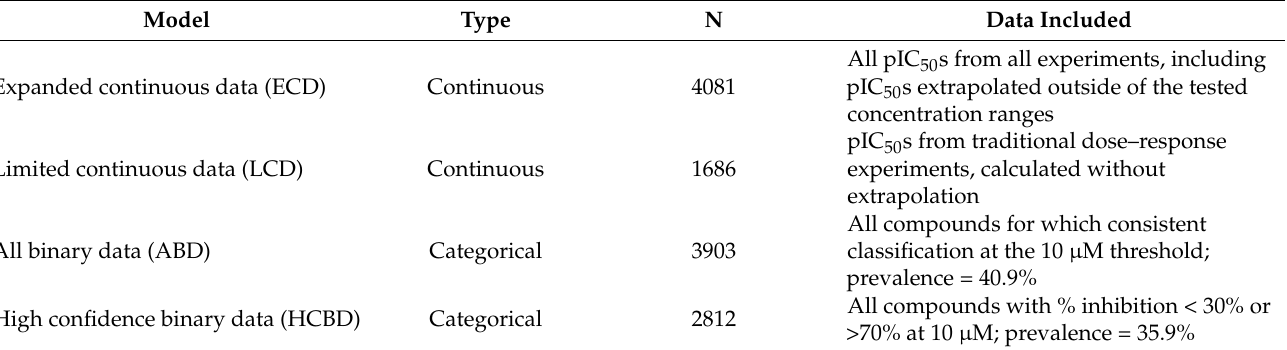
Table 1. Model training set summary.